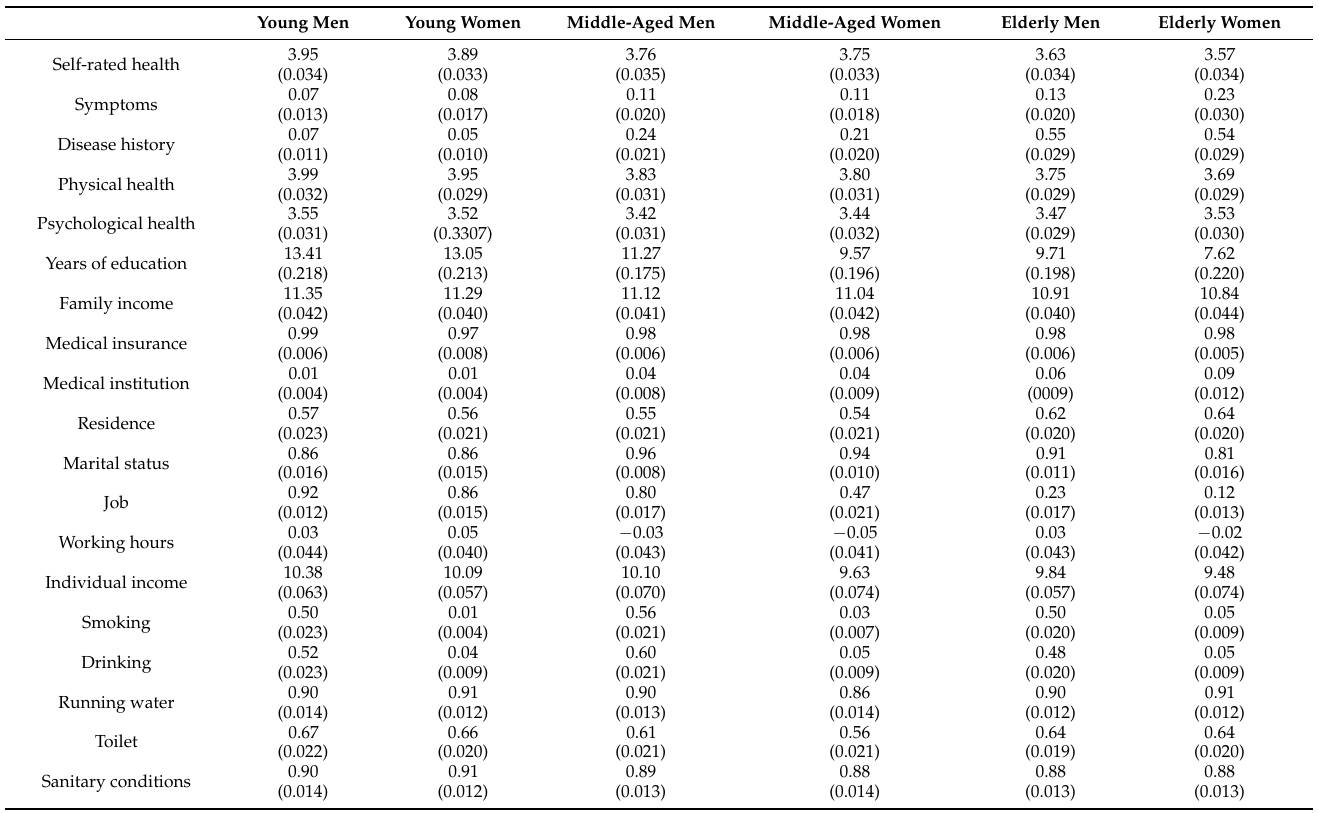
Table A2. Summary statistics of physical and psychological health (by age and sex).